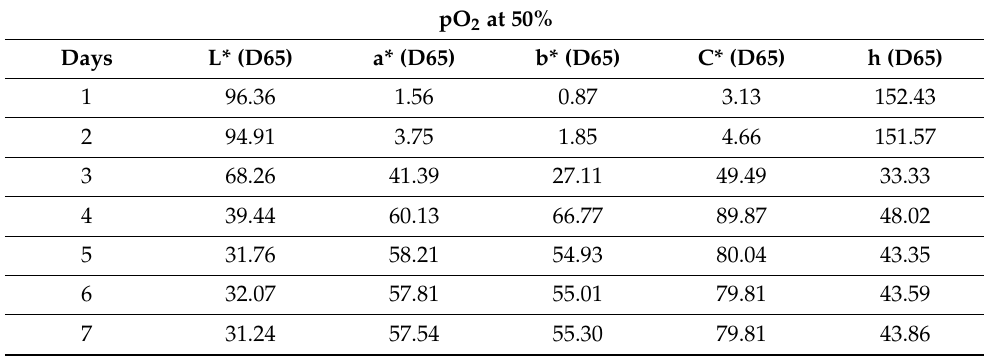
Table 4. Colorimetric (D65) values L*a*b*c*h of extracellular extracts from 2 L bioreactor fermentation with pO 2 at 50%.